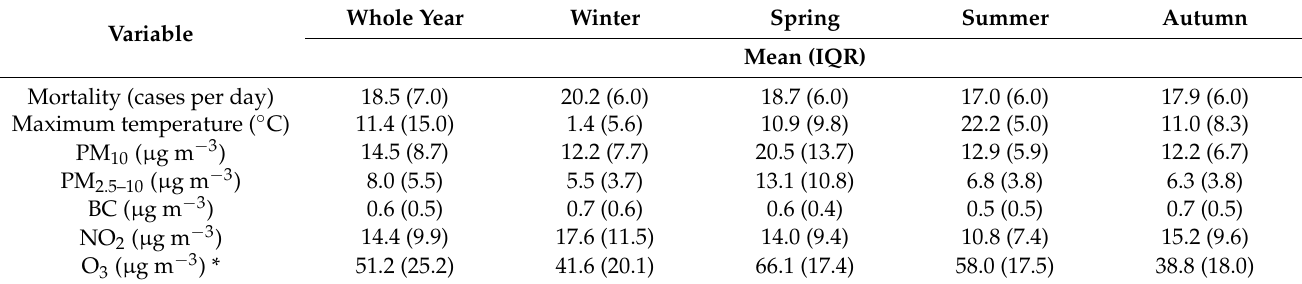
Table 2. Summary statistics of the daily data from 2000 to 2016 during whole year and in four different seasons. Whole Year Winter Spring Summer Autumn Variable Mean (IQR) Mortality (cases per day) 18.5 (7.0) Maximum temperature ( ◦